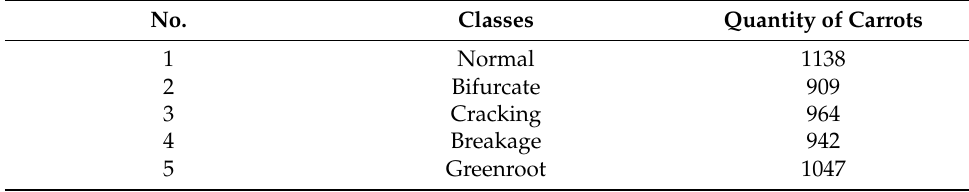
Table 1. The categories of carrot: Normal; Bifurcate; Cracking; Breakage, and Greenroot. No. Classes Quantity of Carrots 1 Normal